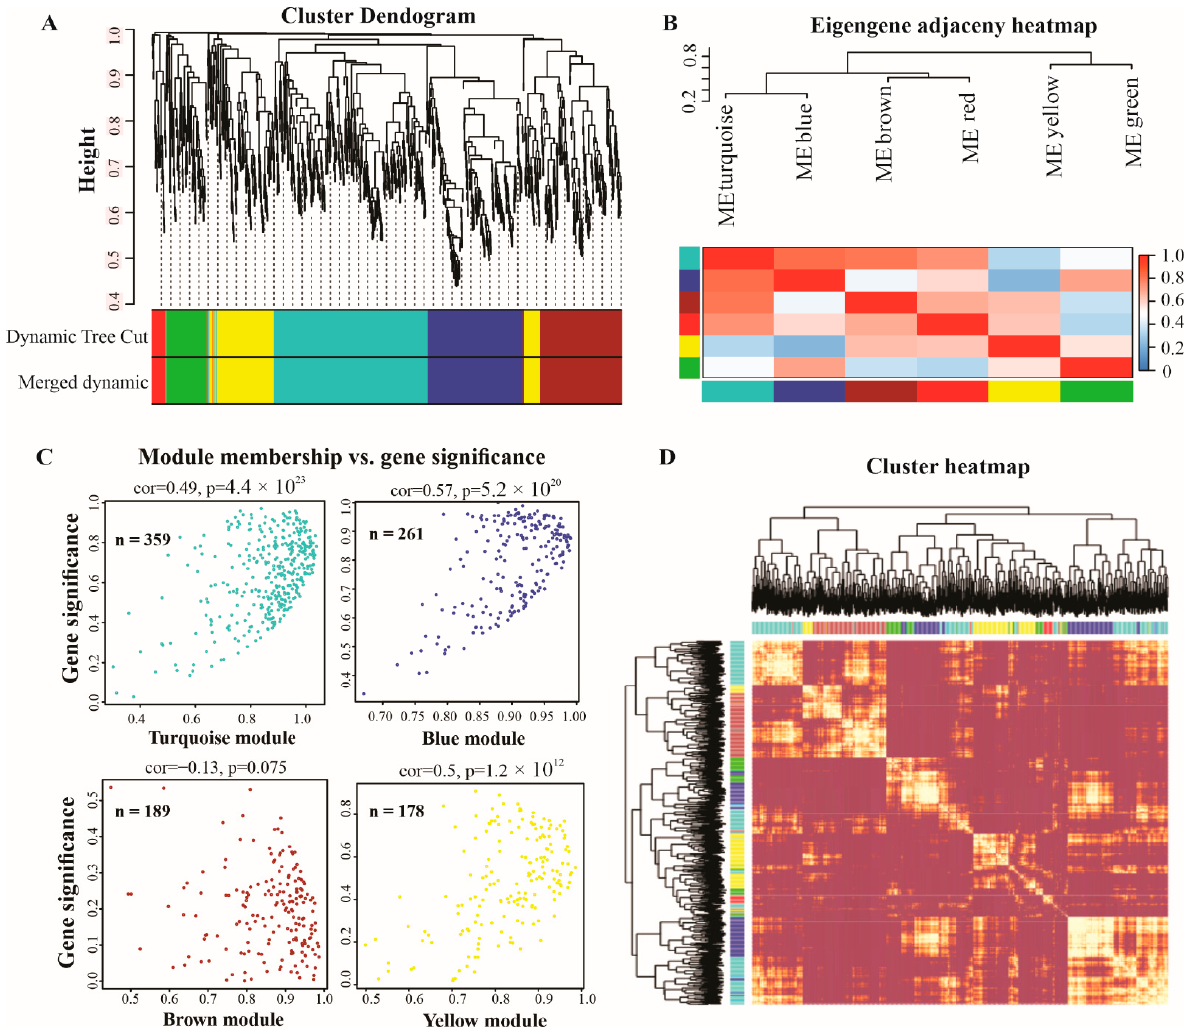
Figure 4. Weighted correlation network analysis (WGCNA) of lncRNAs in white lupin. ( A ) The average linkage hierarchical clustering dendogram of lncRNAs. ( B ) Modules, designated by color code, are the branches of the clustering tree. Unsupervised hierarchical clustering dendogram and heatmap. ( C ) Scattered plot of gene significance versus module membership in the most significant four modules (turquoise, blue, brown, and yellow) of lncRNAs. ( D ) Cluster heatmap representing the Topological Overlap Matrix (TOM) among all lncRNAs in the analysis. The degree of overlap is represented by the color shade; a darker color represents a higher overlap and a lighter color represents a lower overlap. The lncRNA dendogram is shown on the left, and the module assignment is shown at the top.